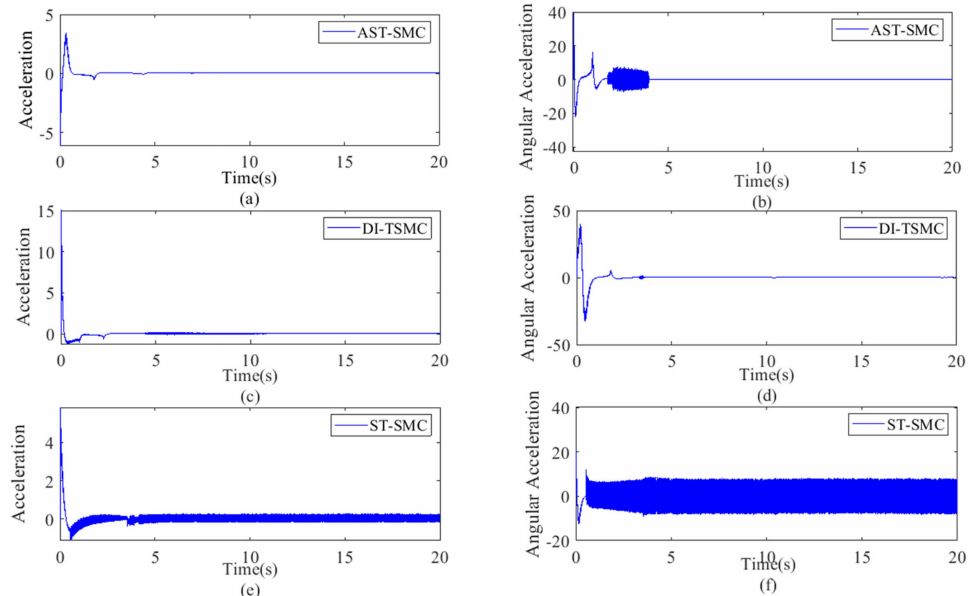
Figure 6. Comparisons of the control inputs from the follower 3. ( a ) Acceleration by AST-SMC, ( b ) angular acceleration by AST-SMC, ( c ) acceleration by DI-TSMC, ( d ) angular acceleration by DI-TSMC, ( e ) acceleration by ST-SMC, ( f ) angular acceleration by